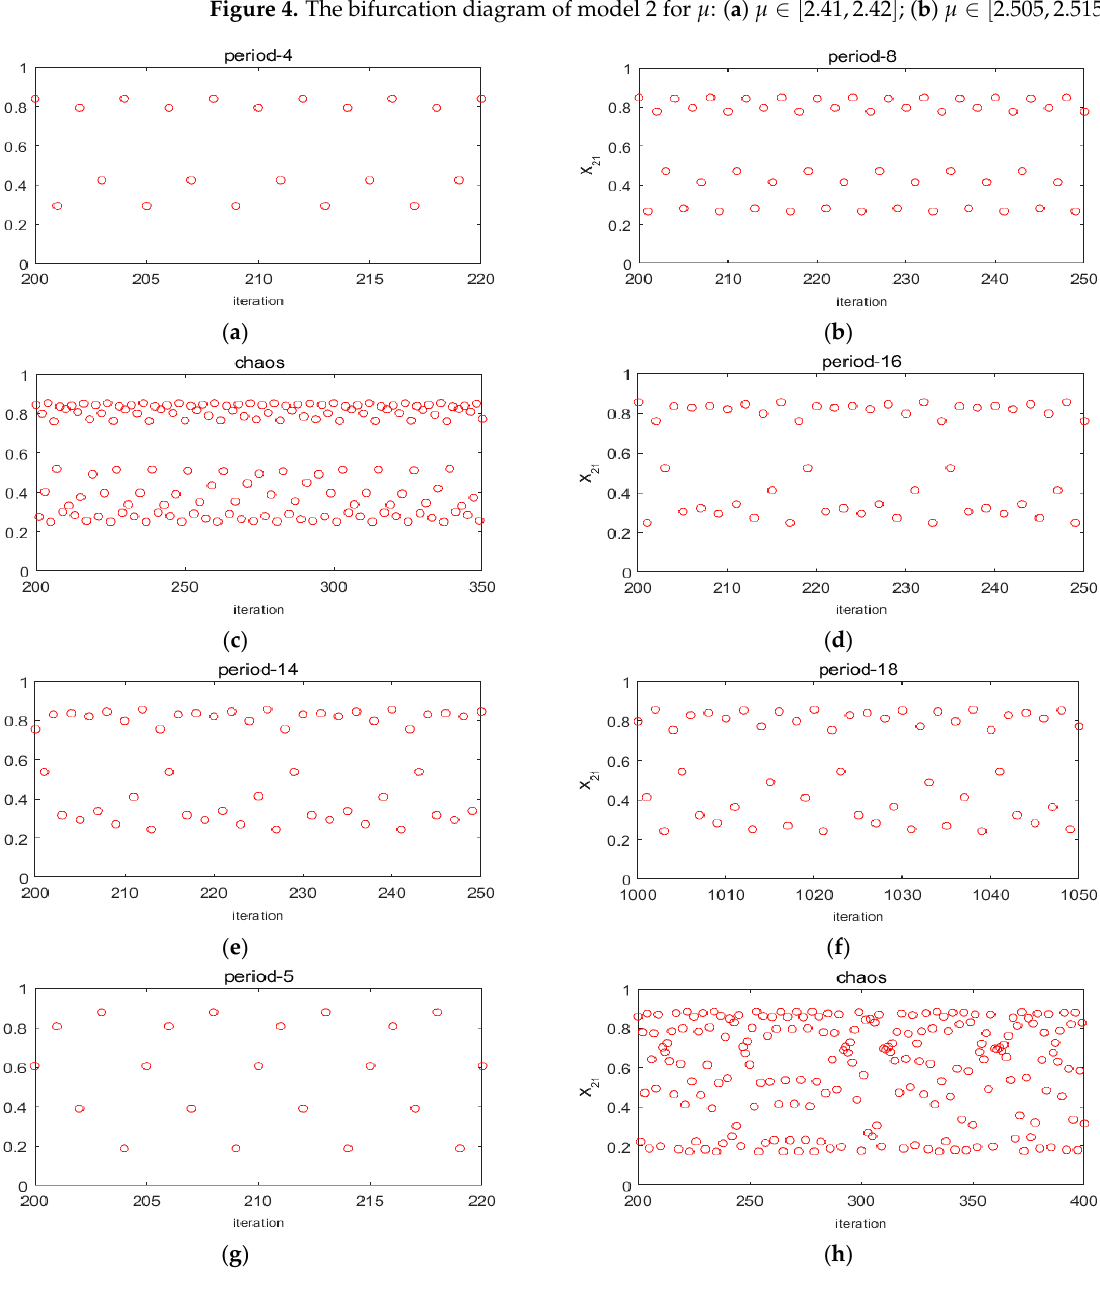
Figure 5. The time series (each circle represents one data) of model 2 for different parameters µ : ( a ) µ = 2.35; ( b ) µ = 2.385; ( c ) µ = 2.41; ( d ) µ = 2.4112; ( e ) µ = 2.4168; ( f ) µ = 2.419; ( g ) µ = 2.508; . ( h ) µ = For cases where 2.39 μ= , the tra ffi c system is in a periodicity condition, and the travel units move steadily. It is seen that although the tra ffi c system varies (e.g., due to the opposite for cases where μ is larger than 2.39. Although the tra ffi c system runs smoothly within the chaotic region’s periodic window, once disturbed, it may be very